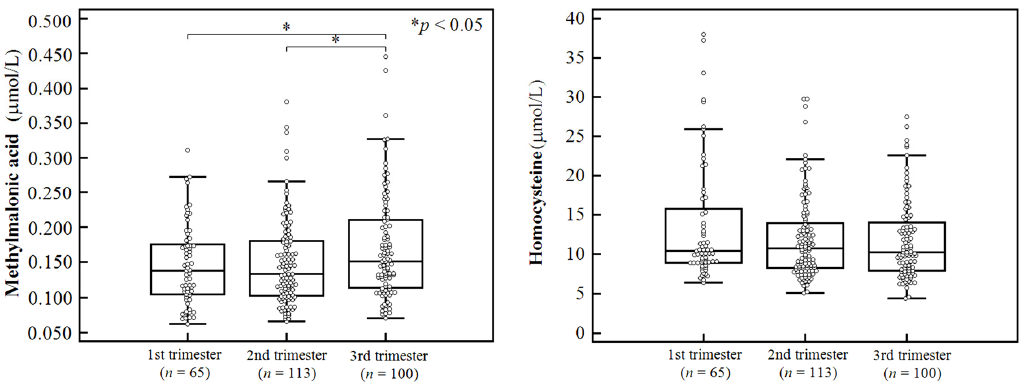
Figure 2. Serum methylmalonic acid and homocysteine levels in all trimesters.